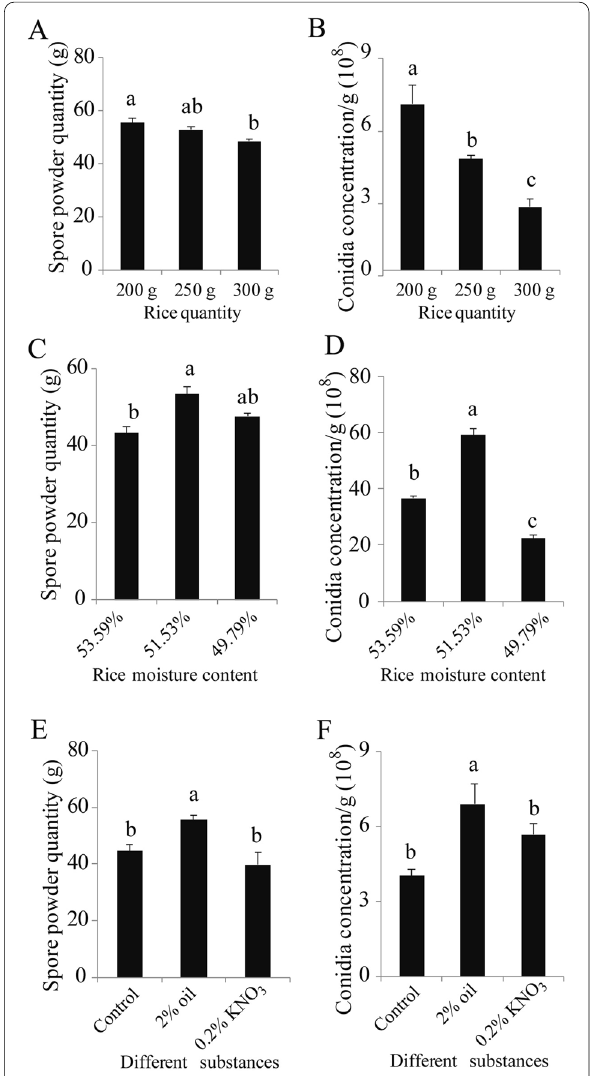
Fig. 3 Effects of rice quantity ( A , B ), media moisture level ( C , D ), and supplementation with 2% cooking oil or KNO 3 ( E , F ) on conidia production. Bars with same letters were not significantly different in Duncan’s test